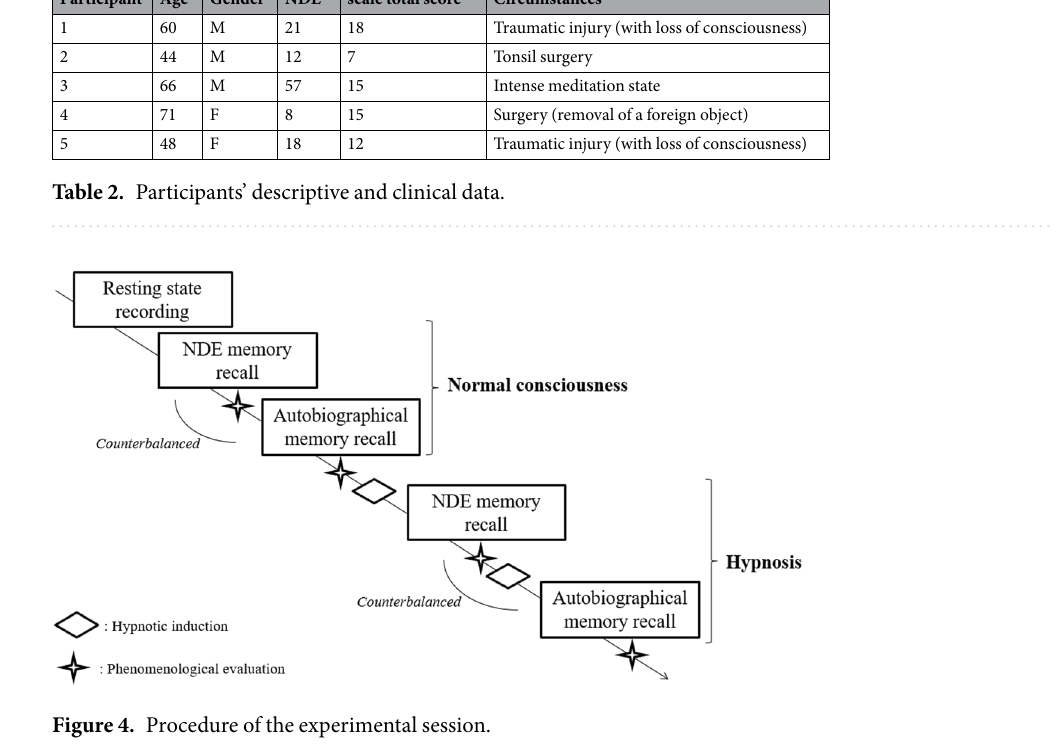
Figure 4. Procedure of the experimental session.